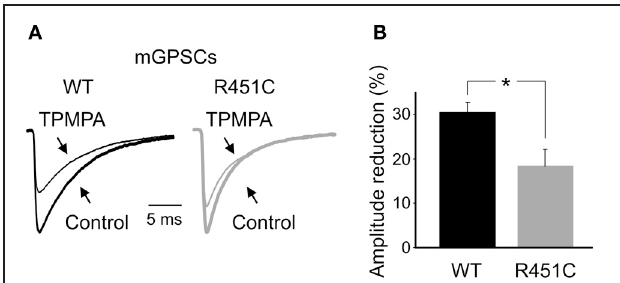
FIGURE 4 | Increased synaptic GABA transient in NL3 R451C knock-in mutant mice. (A) Sample traces of mGPSCs recorded from NL3 R451C mutants (gray) and littermate (black), in the absence (tick line, Control) and in the presence of TPMPA (200 μ M; thin line). The amplitudes of mGPSCs from NL3 R451C knock-in mice were normalized to those obtained from WT animals. (B) Each column represents the mean TPMPA-induced reduction in amplitude of mGPSCs in WT (black; n = 8) and NL3 R451C mice (gray; n = 7). ∗ p < 0 . 05.